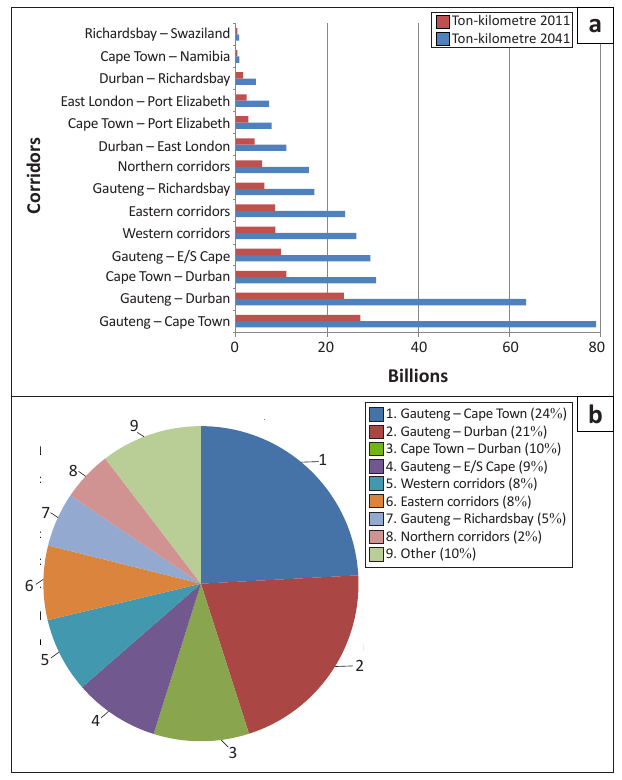
FIGURE 6: Corridor growth and relative current size (a) 2011 vs 2041 and (b) 2011